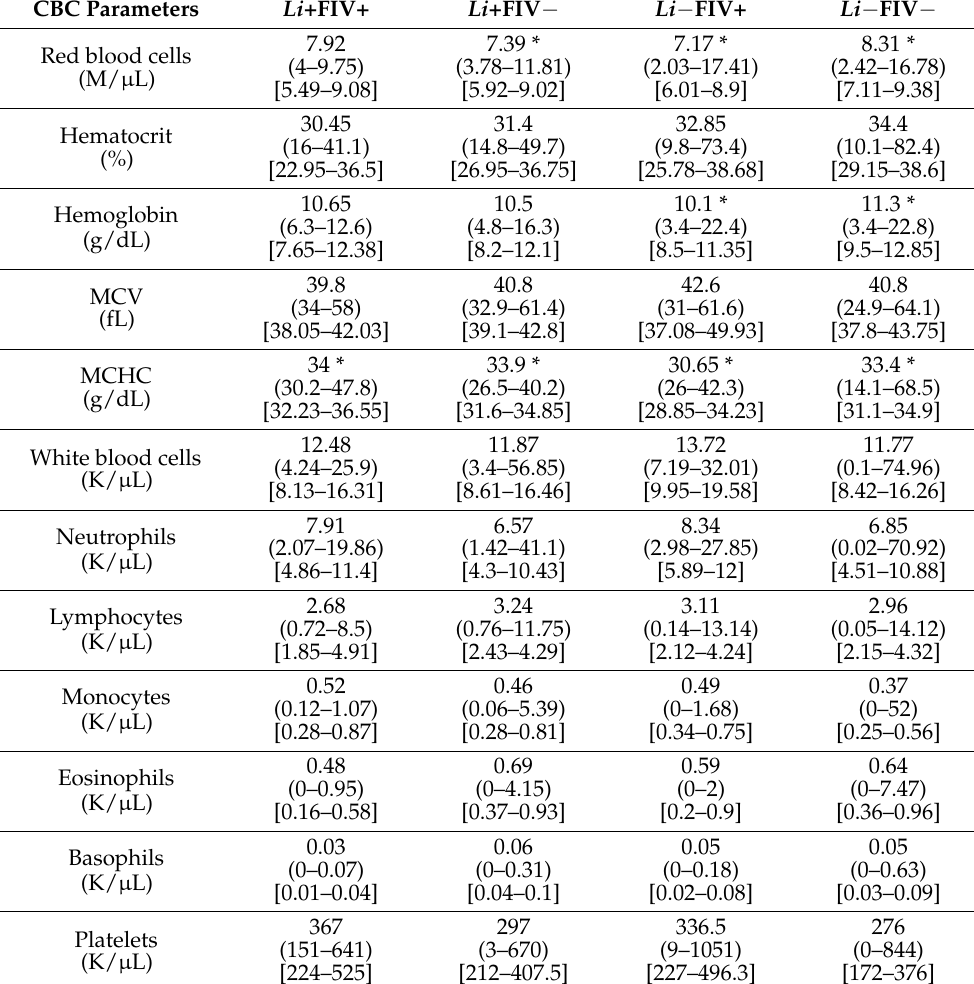
Table 4. Median (minimum–maximum) (25 ◦ percentile; 75 ◦ percentile) of complete blood count (CBC) values of cats classified according to their infection patterns considered ( Li +FIV+; Li +FIV − ; Li − FIV+; Li − FIV −